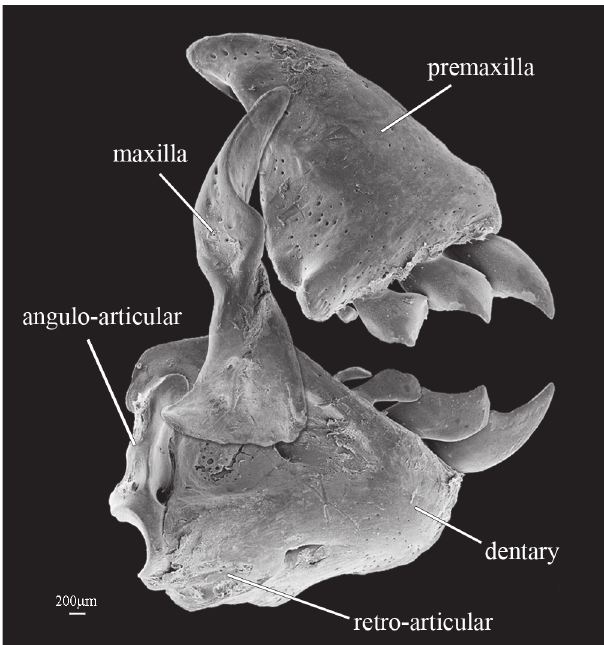
Fig. 2. Upper and lower jaws of Leporinus santosi , MZUSP 32307, 121.1 mm SL, in lateral view.